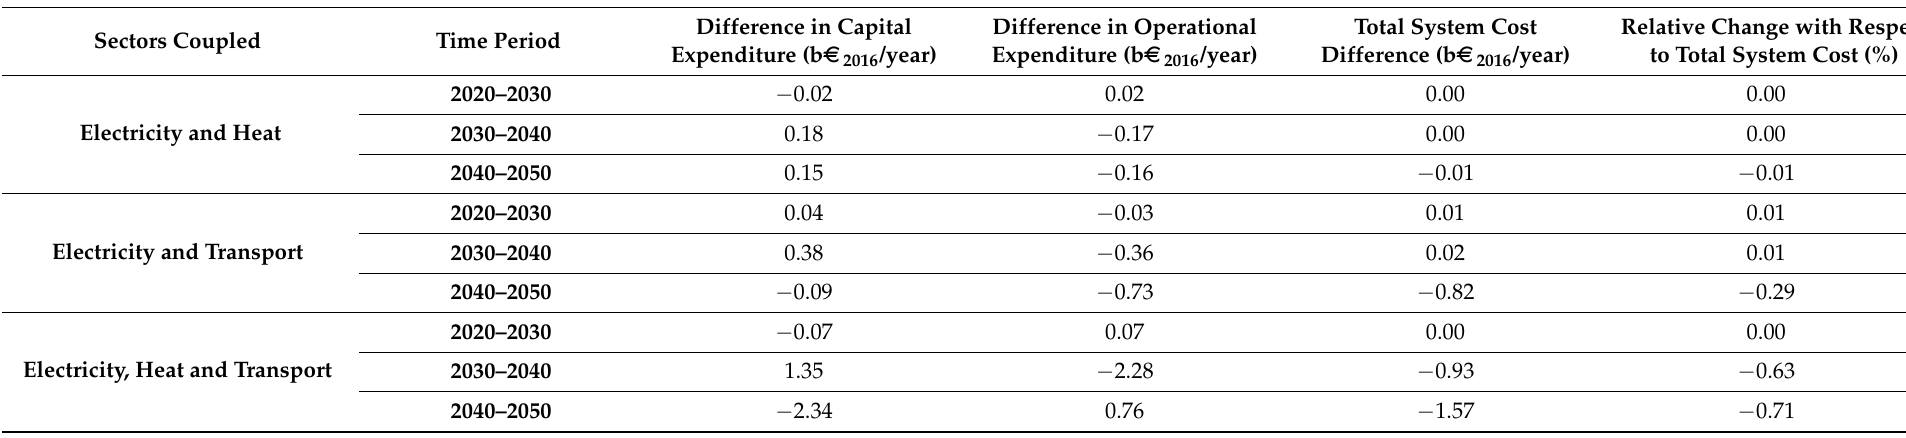
Table 5. Influence of sector coupling on the value of offshore grids. Cost difference and relative change is calculated between the scenarios and a reference in which offshore grid investments are not allowed. Only scenarios with offshore grid investments are